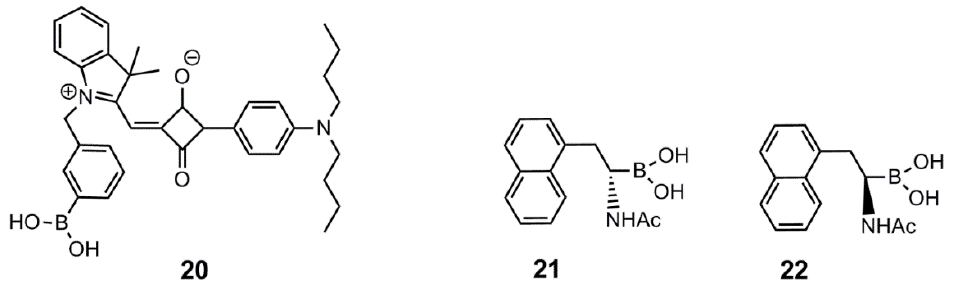
Figure 5. The near-infrared squarylium cyanine boronic acid dye, 20 , reported by Saito and co-workers [58], and the two enantiomeric  -amidoboronic acids, 21 and 22 , reported by Wang and co-workers